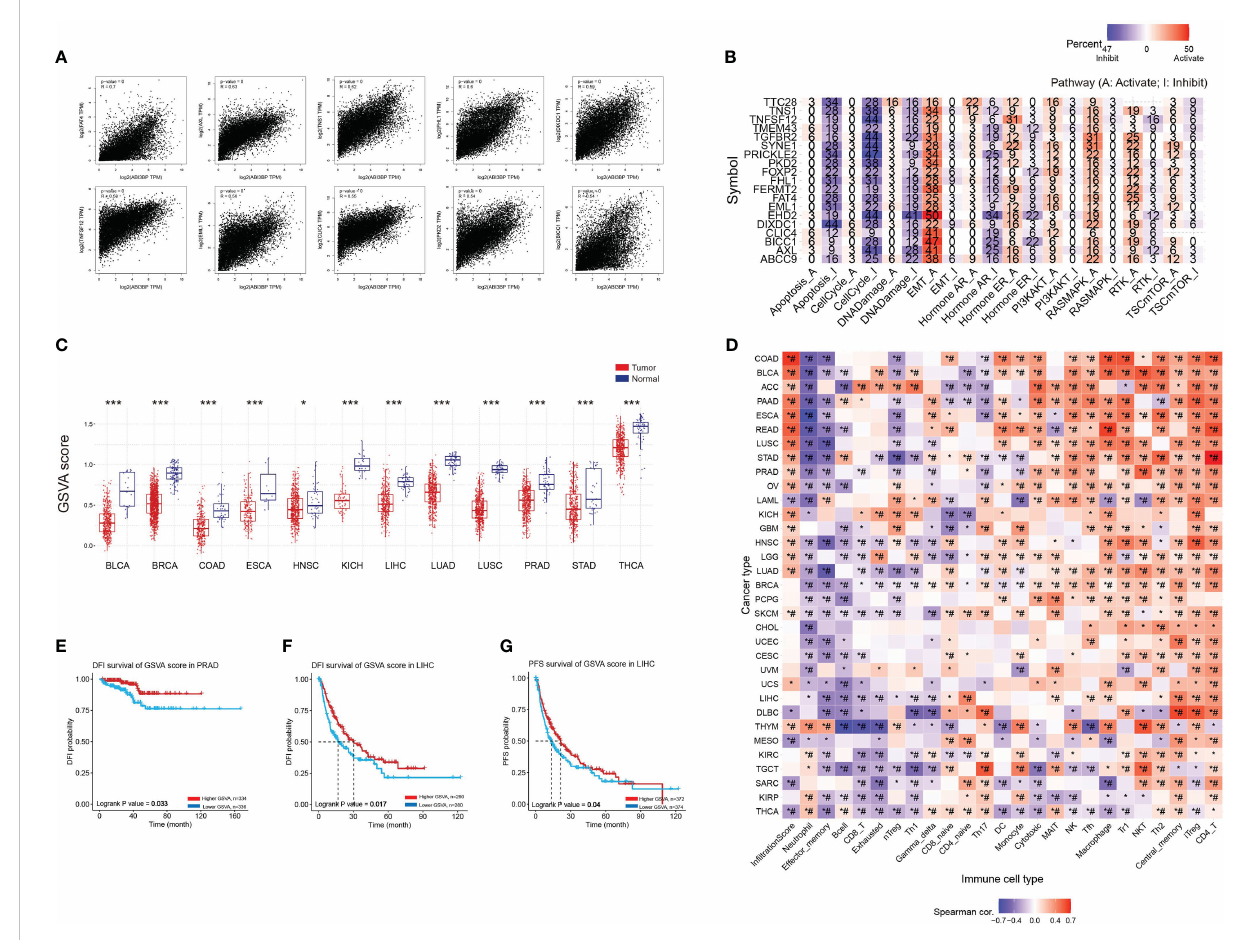
FIGURE 9 GSVA scores of ABI3BP-related genes and their association with immune in fi ltration. (A) The top 20 genes with the strongest interaction with ABI3BP were screened in the GEPIA website, and the scatter plots of the associations of the top 10 genes are shown. (B) roles of top 20 genes in cancerrelated pathways. (C) GSVA scores of the top 20 genes. (D) relationship between gene sets and immune in fi ltrating cells. (E – G) Relationship between GSVA score of gene sets and patient outcomes. *, p < 0.05; ***, p < 0.001; #, FDR ≤